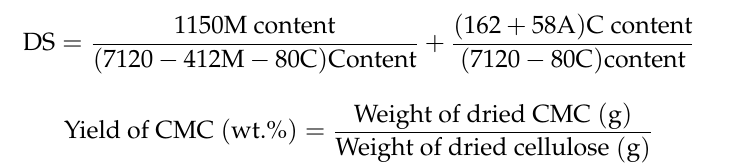
polyethylene glycol bag. Different concentrations of NaOH (20, 30, 40, 50, and 60) and 350 mL of isopropanol were blended with 15 g of cellulose powder. The etherification reaction solution was heated (45 – 75 °C, 1 h) and then filtered. The filtrate was suspended in methanol (100 mL) and neutralized with acetic acid (10 mL) to form a yellowish solid product. The solid product was washed with ethanol (5 times, 50 mL), followed by a one-time wash with absolute methanol to remove sodium glycolate and chloride, and then dried (temperature: 60 °C, time: 3 h) [59,60]. After determining the desired source for cellulose extraction and CMC synthesis, calculation of the degree of CMC substitution is required. The degree of substitution (DS) of CMC (Equation (1)) means the average